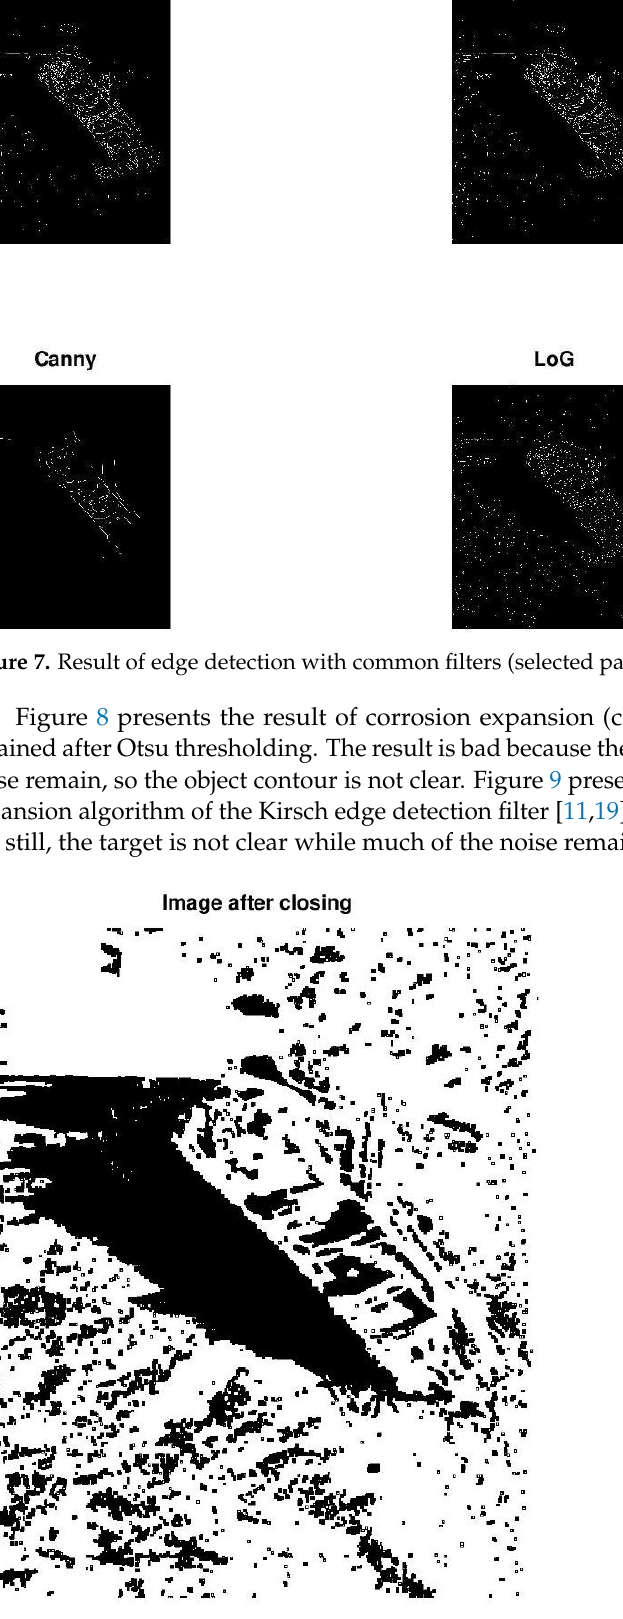
Figure 8. Corrosion expansion on the Otsu binary